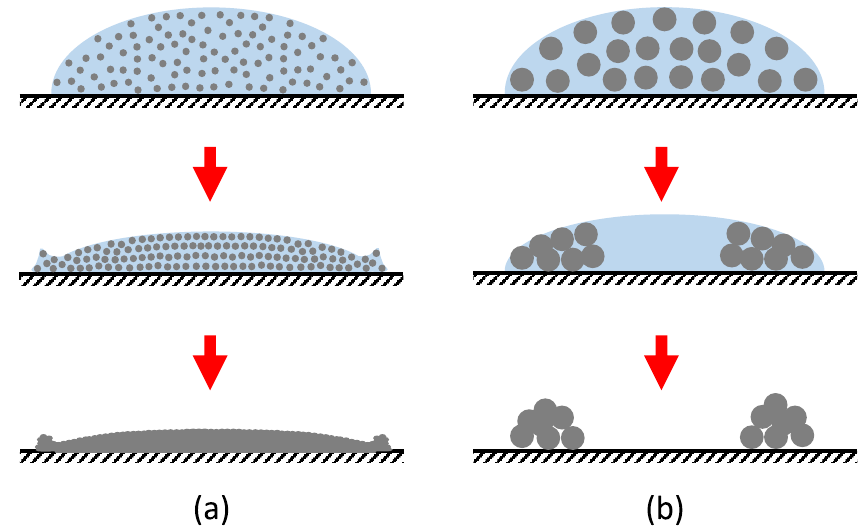
Figure 4. Schematic illustration of dryout process as a function of the nanoparticle size: ( a ) smaller nanoparticles (such as 2-nm Au); and ( b ) larger nanoparticles (such as 47-nm Al 2 O 3 ). Smaller nanoparticles, which increase the nanofluid viscosity, tend to quench the thermally driven nanoparti- cle motion, which results in a thicker and more uniform dryout pattern in the central region with a loosely defined wider ring in the rim area